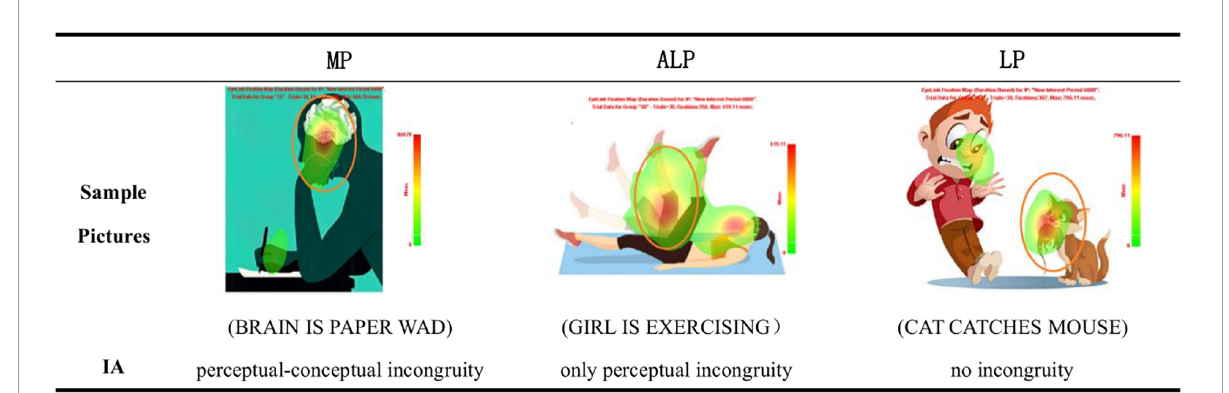
FIGURE1 Experimental procedure.